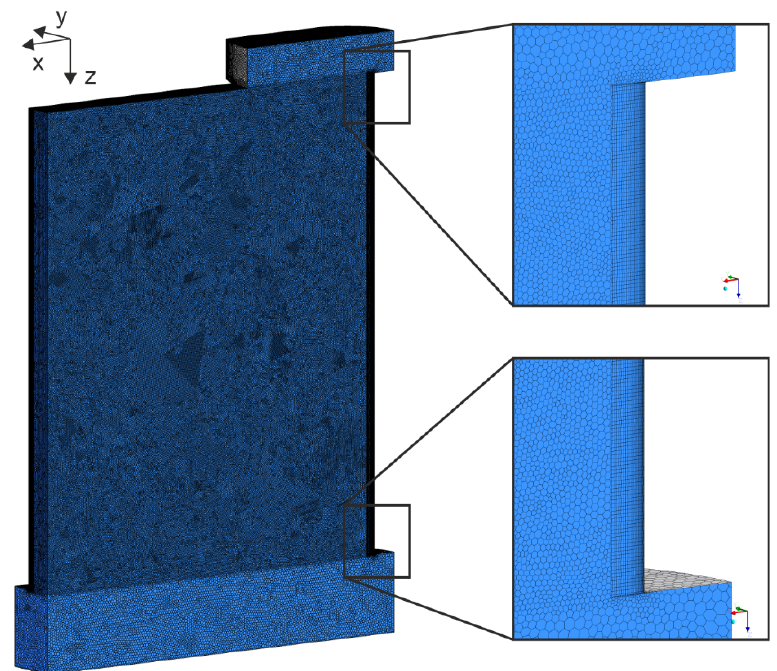
Figure 2. Surface mesh and detailed views of the prism layers at front top and bottom